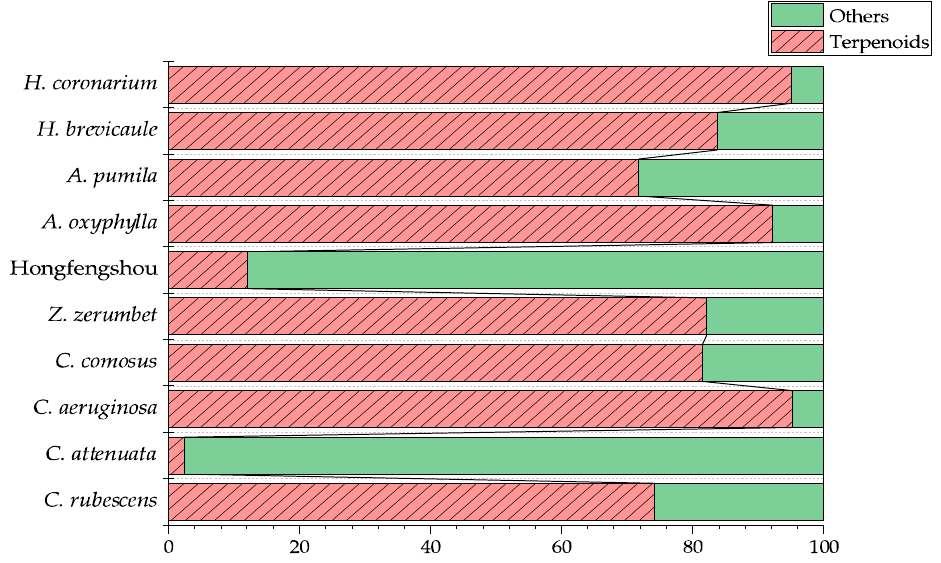
Figure 5. Total amount of terpenoids and others in ten Zingiberaceae plants. The values represent the proportion of terpenoids and others in each of the plants.